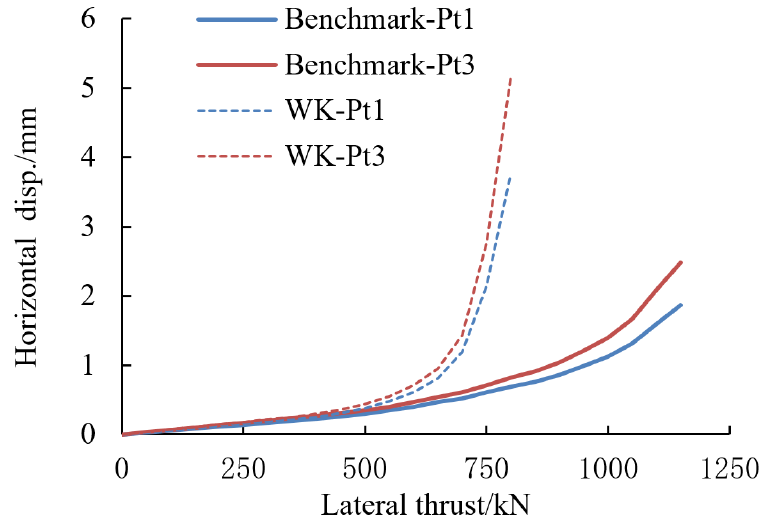
Figure 23. Comparison of DEM predicted displacements with/without anti-slip measures at the overloading phase.